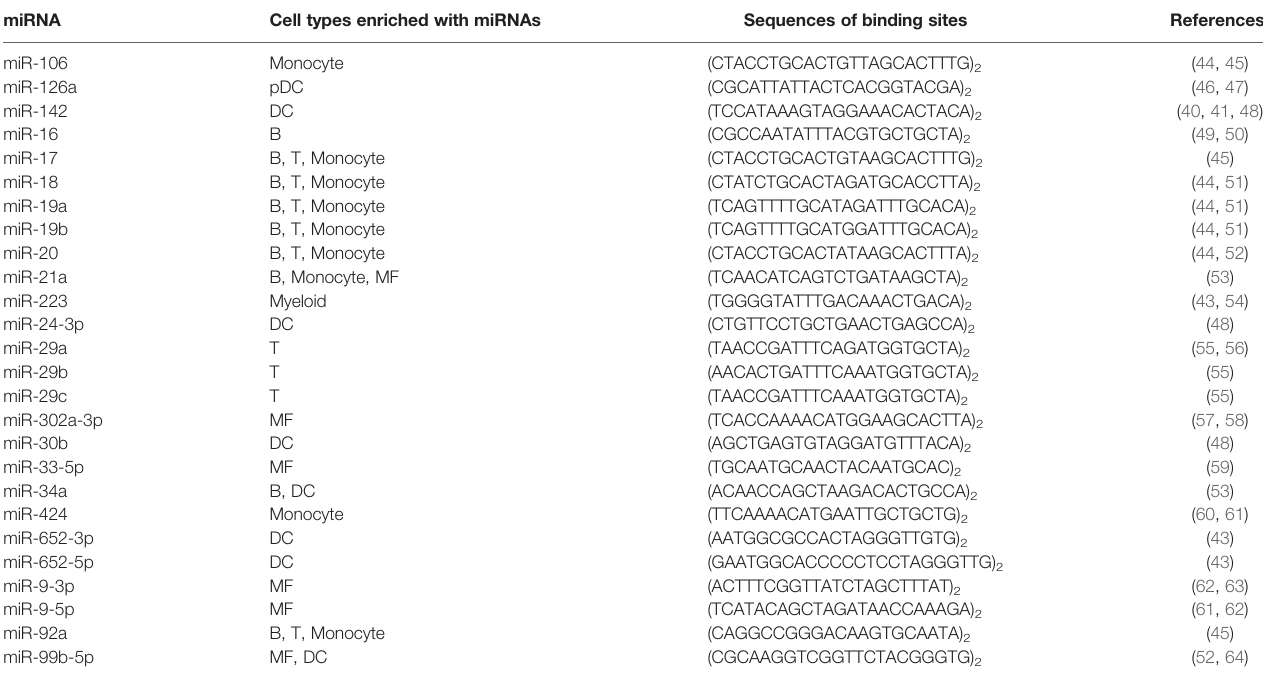
TABLE 1 | List of candidate miRNA binding sites shortlisted for in vitro screening. miRNA Cell types enriched with miRNAs Sequences of binding